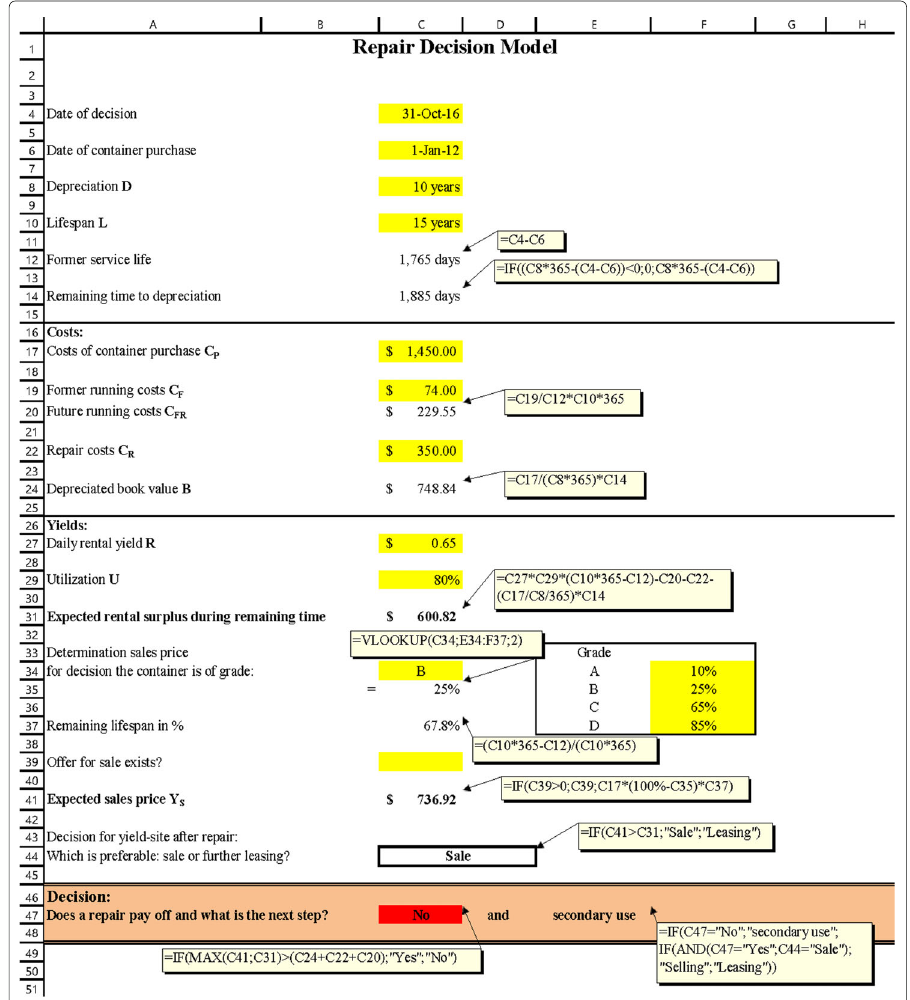
Fig. 6 The decision model implemented in Excel with displayed comments; here, case c (see p. 17) is displayed as an